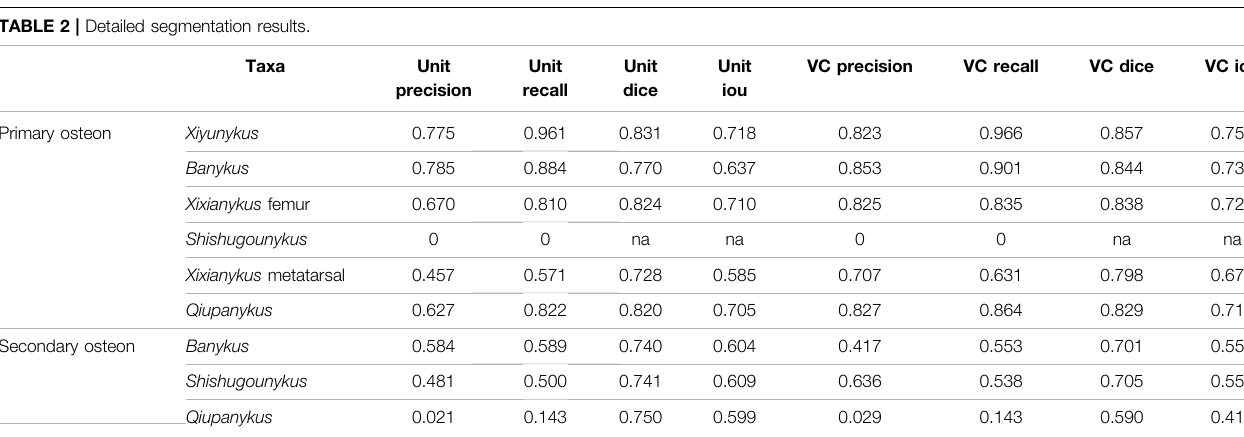
TABLE 2 | Detailed segmentation